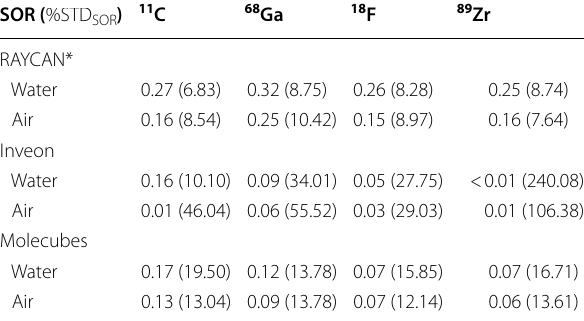
*System has no data corrections for randoms and scatter